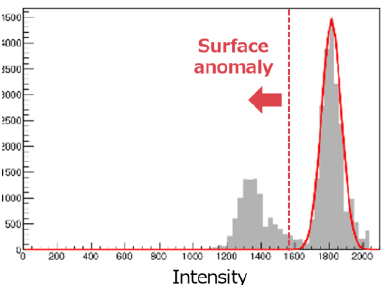
Figure 6. Histogram of intensity for partially corroded